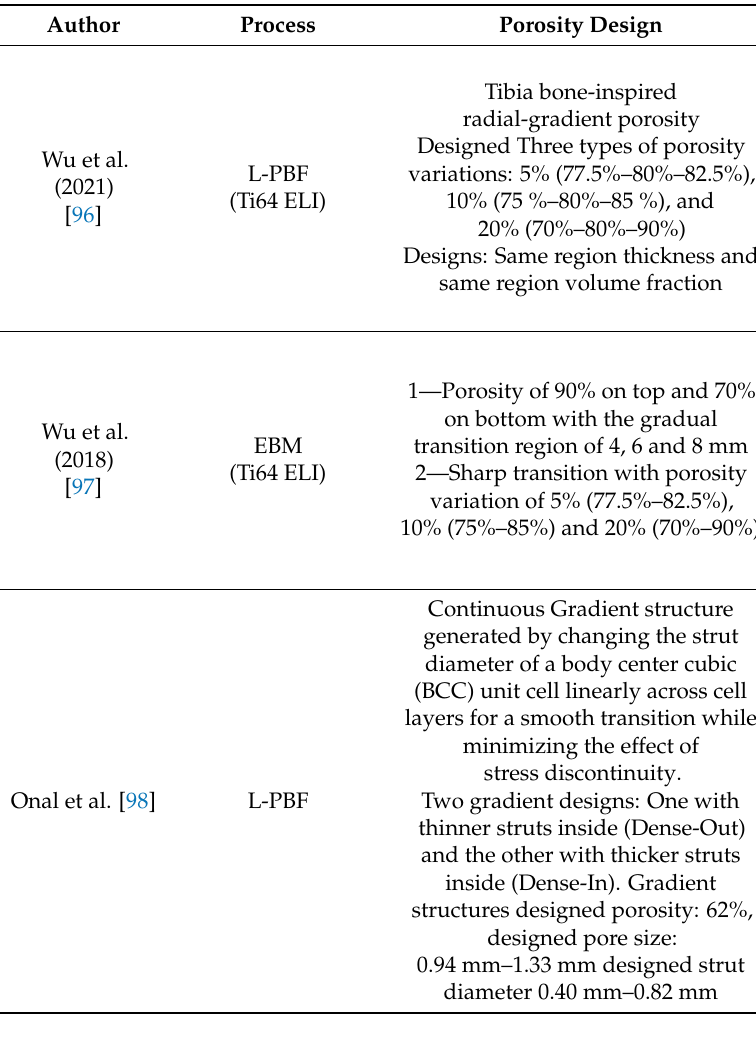
Table 3. Mechanical Properties of Gradient Porous